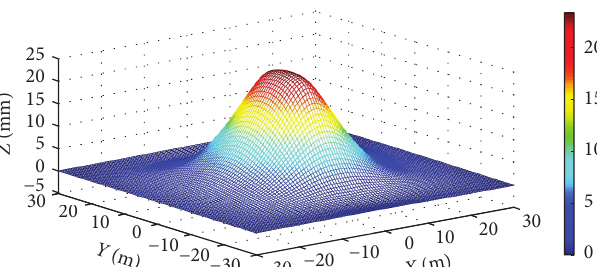
Figure 13: Heaving displacement of the ground surface caused by freezing for 75 days (mm, α � 0 ° ).